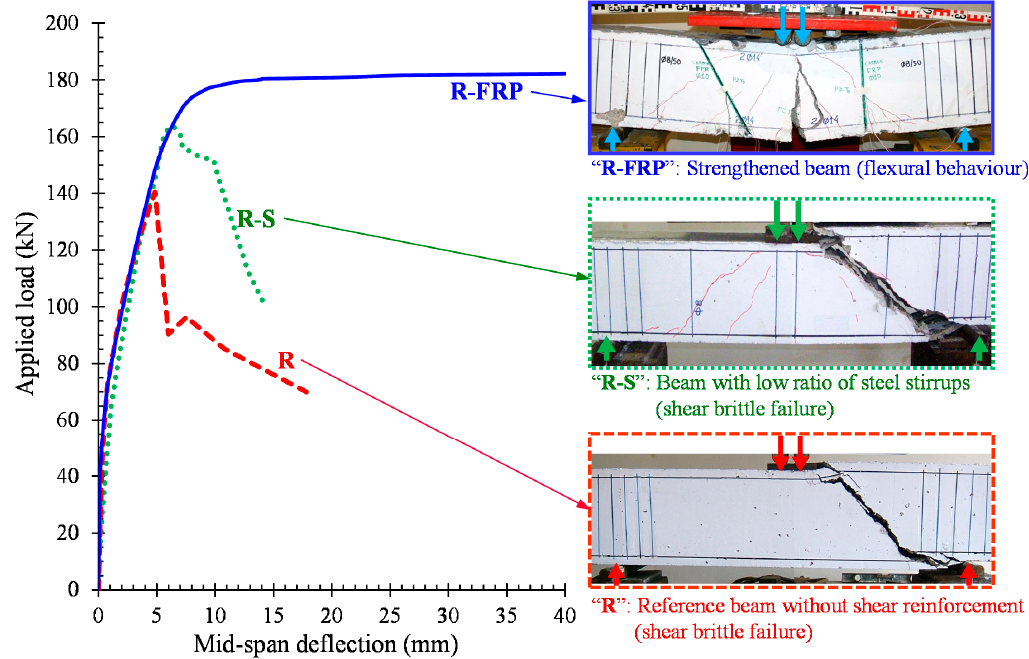
Figure 7. Experimental response and cracking patterns at failure of the tested beams with rectangular